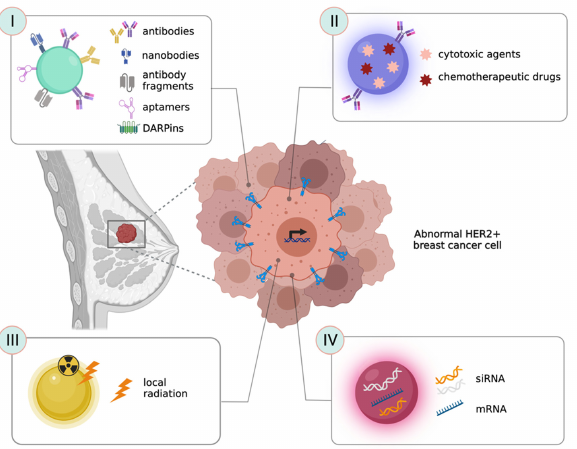
Figure 1. Strategies for HER-2 + BC therapy ( I ) NPs functionalized with HER-2 targeting ligands ensure a specific targeting into HER-2 + cancer cells; ( II ) NPs can vehicle chemotherapeutic drugs or cytotoxic agents into HER-2 + cancer cells; ( III ) NPs functionalized with photothermal agents can promote local radiation to obtain tumor ablation; ( IV ) NPs can deliver nucleic acids or gene silencing molecules to enable gene expression regulation and overcome the insurgence of resistance to conventional